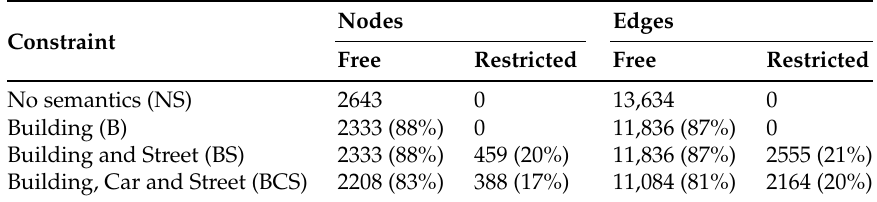
Table 2. Effects of semantic constraints on the graph generation for the synthetic scene. The free airspace is further restricted for various semantical constraints affecting the number of accessible and conditionally accessible nodes. Nodes Constraint